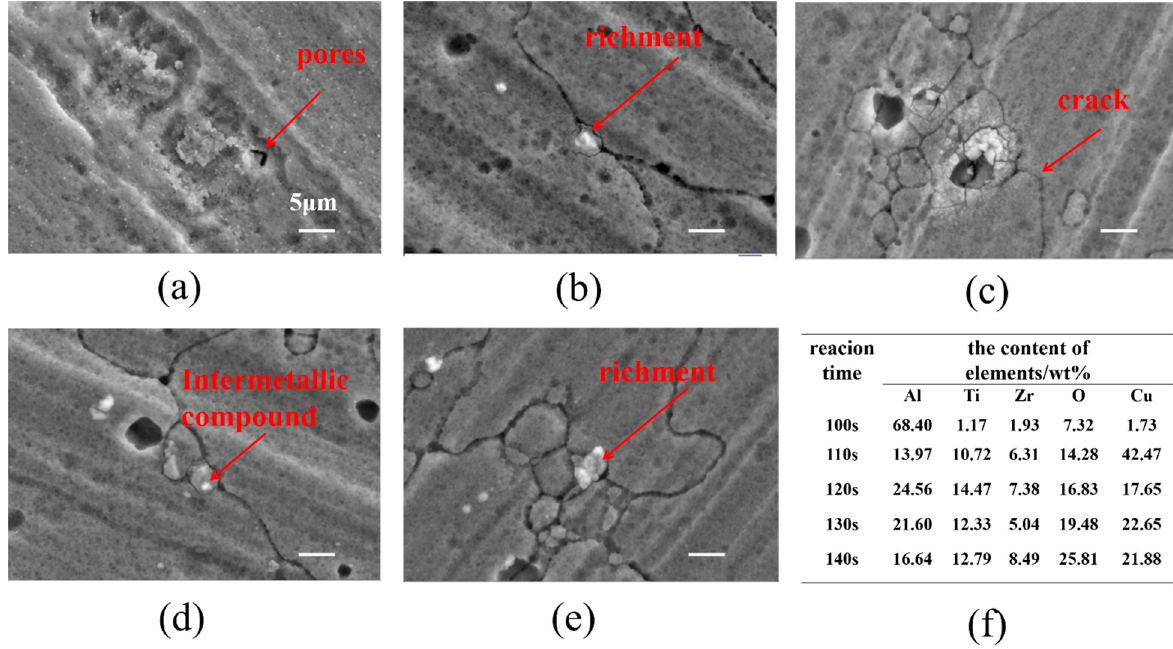
Figure 5. Results of SEM and EDS of 7075 aluminum alloy with synchronous chemical conversion at different times: ( a ) at 100 s, ( b ) at 110 s, ( c ) at 120 s, ( d ) at 130 s, ( e ) at 140 s, ( f ) the EDS result of the conversion coating.